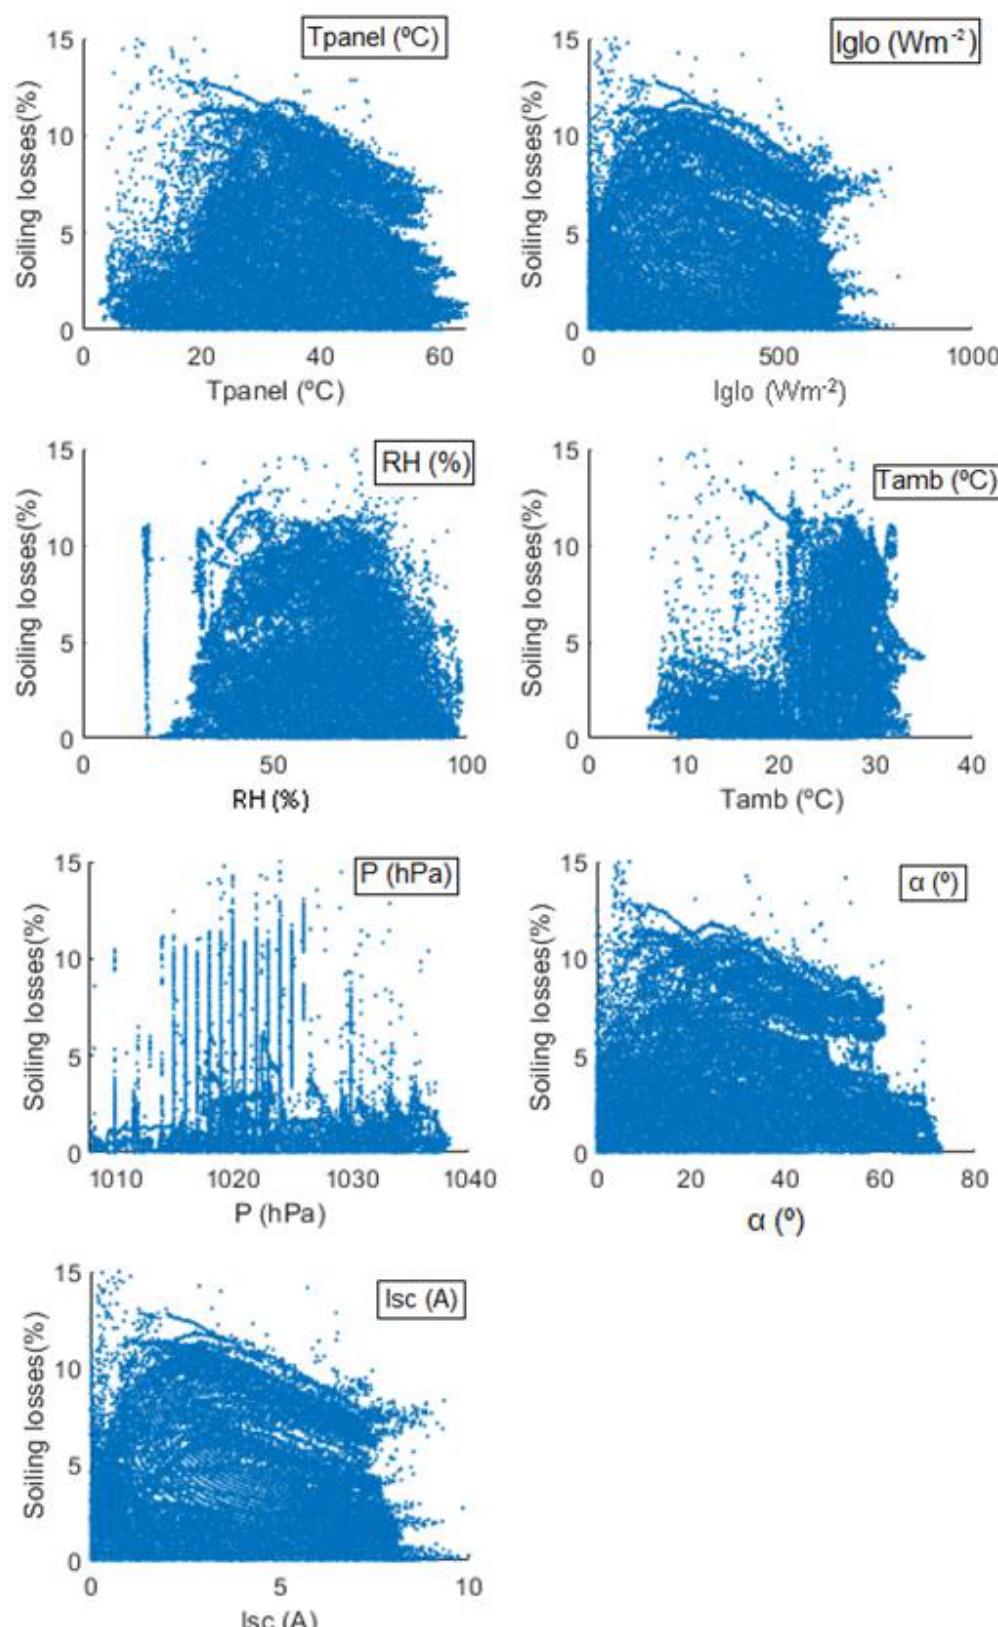
Figure 2. Scatter plots of variables against instantaneous soiling losses. Tpanel: module temperature; Iglo: global irradiation; RH: relative humidity; Tamb: ambient temperature; P: atmospheric pressure; α: solar altitude.